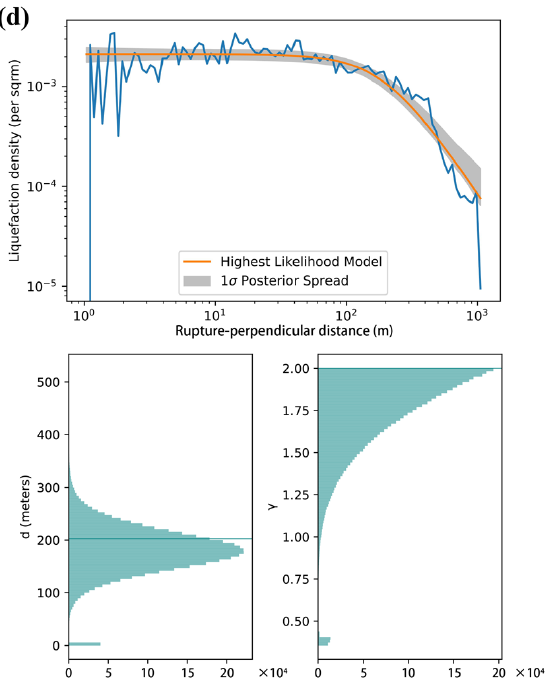
Figure 10. ( a ) The liquefaction susceptibility map of the Maduo Mw 7.4 earthquake, modified by the USGS (https://earthquake.usgs.gov/earthquakes, accessed on 22 May 2021). The yellow points are the coseismic soil liquefaction datasets interpreted based on UAV images. Small red box is location of Figure 10b,c. ( b ) The liquefaction susceptibility distribution in the 10–35 km section west of epicenter (W10–35). ( c ) Density distribution map of coseismic soil liquefaction in W10–35 (from Figure 5b). ( d ) Variation of liquefaction density with increasing distance from the surface rupture in